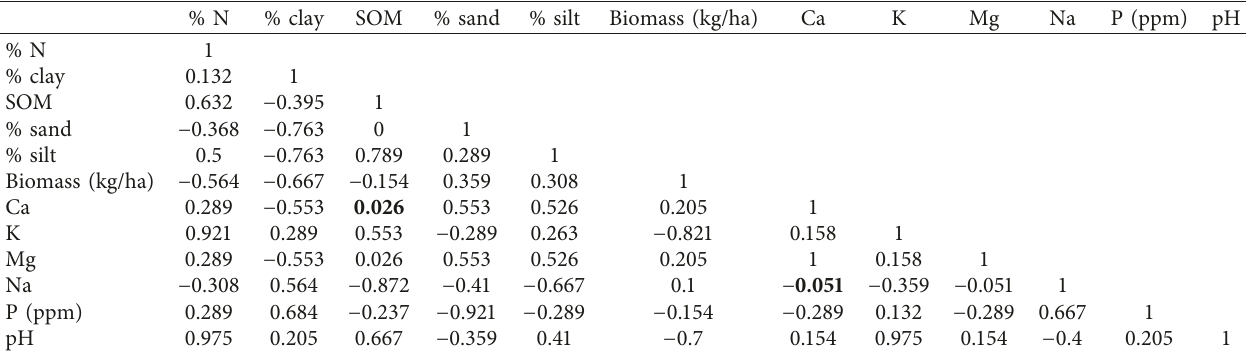
Table 4: Relationship between soil properties and forage quantity in the woodlands.